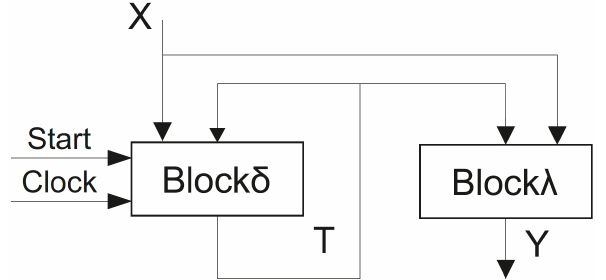
Figure 2. Architecture of LUT-based Mealy FSM U 1